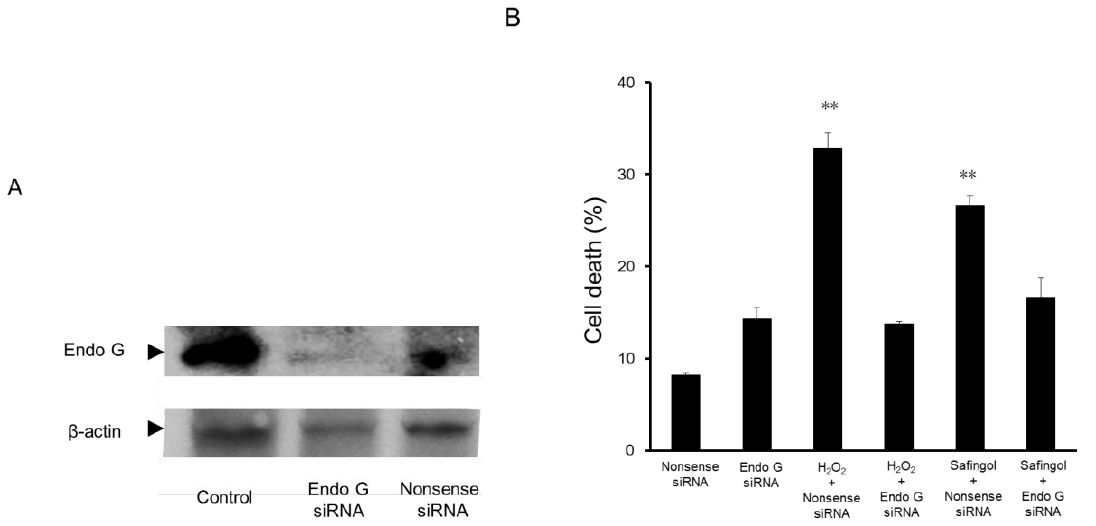
Figure 4. Effect of endo G siRNA transfection on cell viability. ( A ) SAS cells were transfected with endo G siRNA or nonsense siRNA and cultured for 24 h. They were subjected to an immunoblot analysis. At least three determinations were